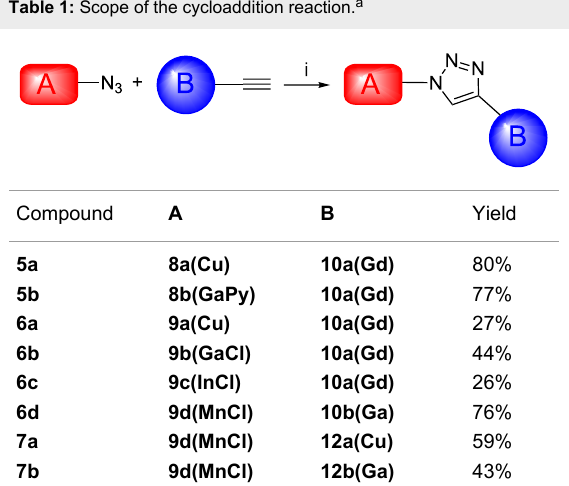
Table 1: Scope of the cycloaddition reaction. a